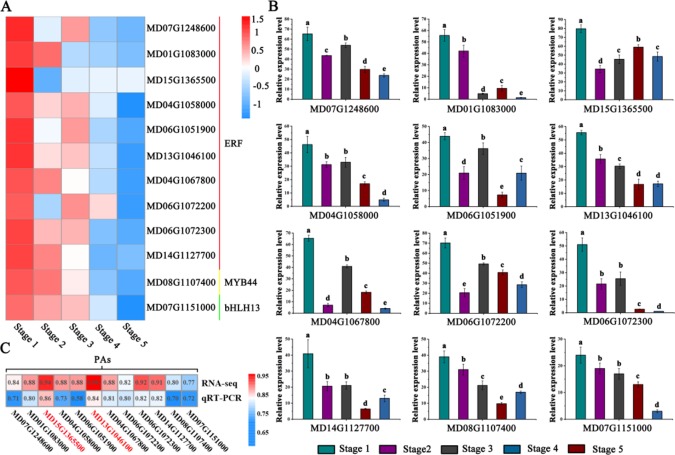
Identification and analysis of PA-biosynthesis-associated transcription factor genes. (A) Heat maps describing the expression profiles of candidate genes related to PA biosynthesis. ERF represents ethylene-responsive transcription factors, MYB represents the R2R3-MYB transcription factor, bHLH represents the helix-loop-helix DNA-binding domain. (B) Validation of RNA-seq expression profiles via qRT-PCR. (C) Correlation analysis between PA accumulation and the expression of related candidate PA regulators via RNA-seq and qRT-PCR data. Different letters above the bars indicate significantly different values (P < 0.05) calculated using one-way analysis of variance (ANOVA) followed by Tukey’s multiple range test.